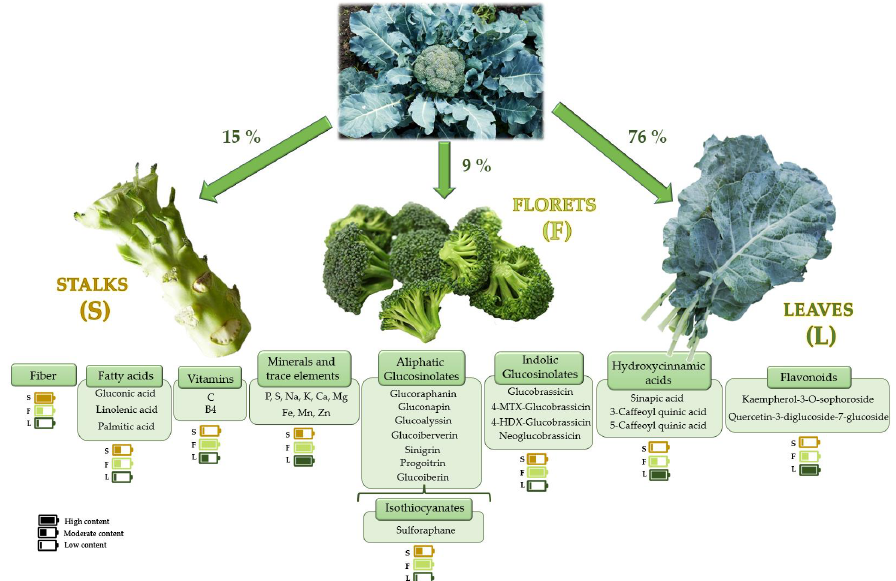
Figure 1. Classification of the main bioactive compounds in broccoli by-products. The content is based on published literature [24 –